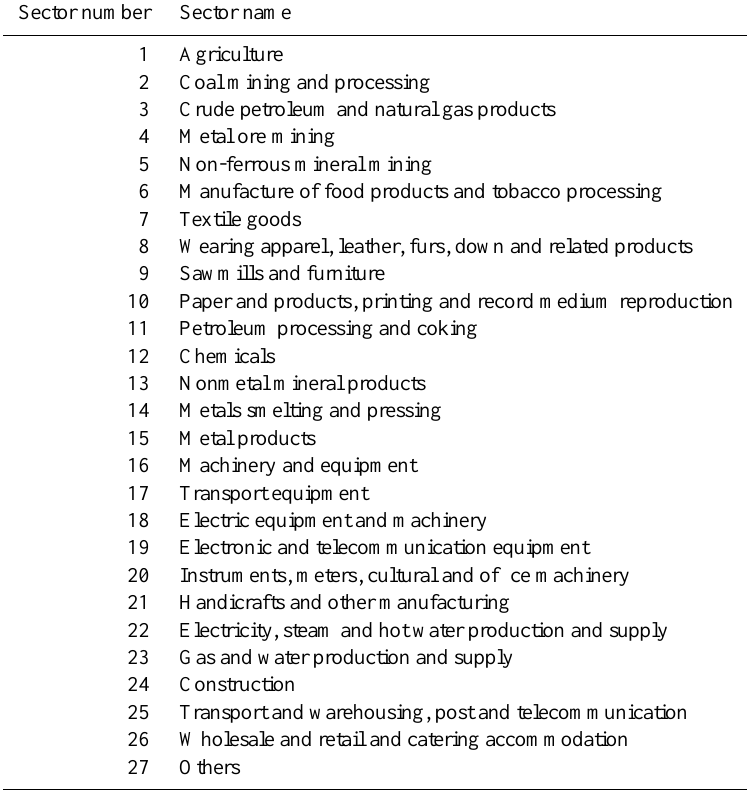
Table A1. Sectors classification for MRIO Table.